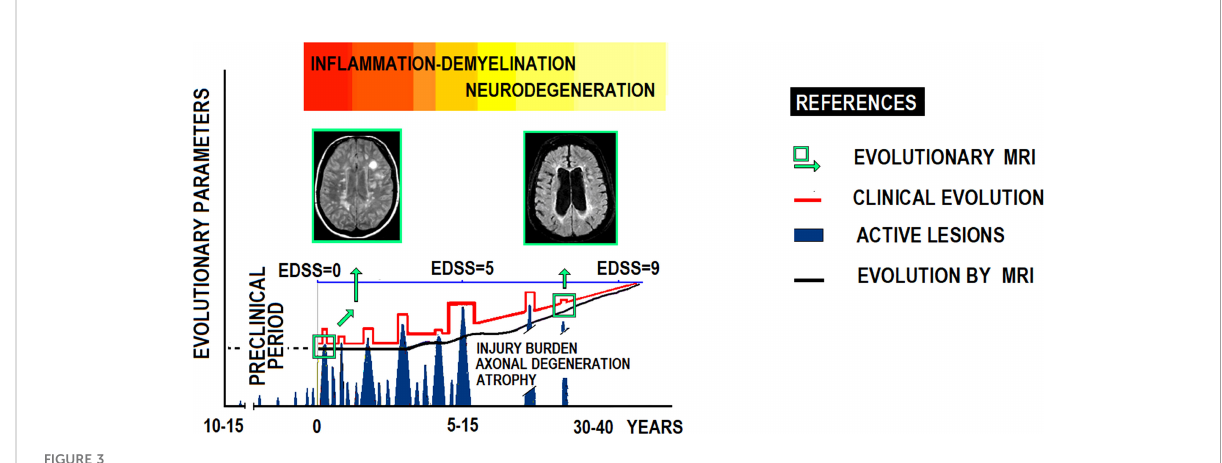
FIGURE 3 Clinicopathological evolutionary pro fi le of